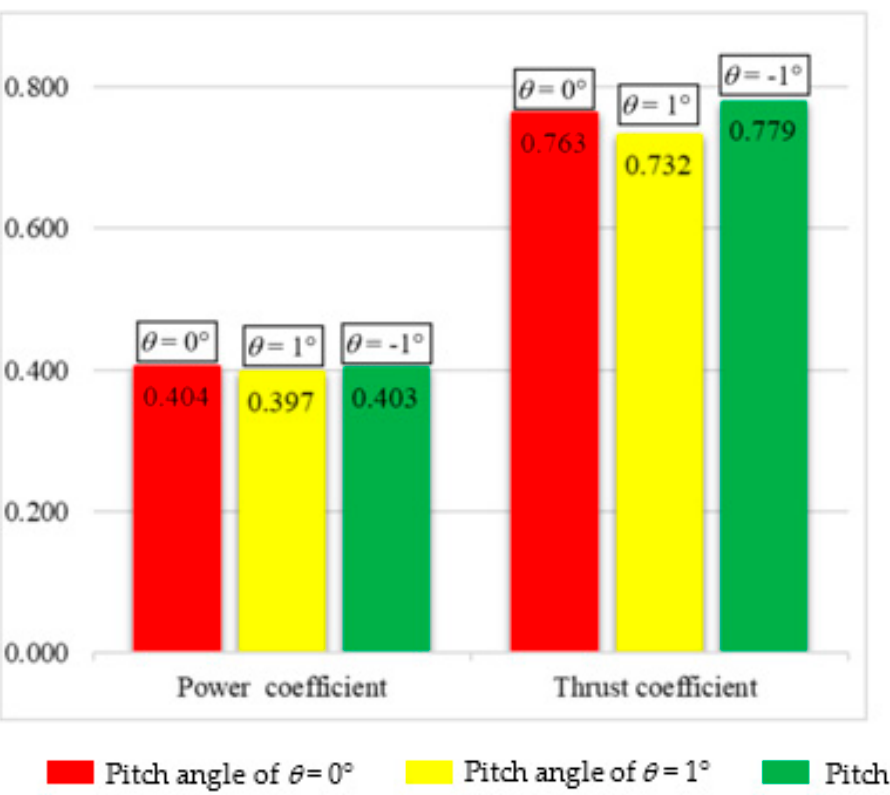
Figure 7. The optimum values of the power and the thrust coefficient are different when the pitch angle changes with θ = − 1°, 1°, and 0° at the yaw angle of φ = 0°.